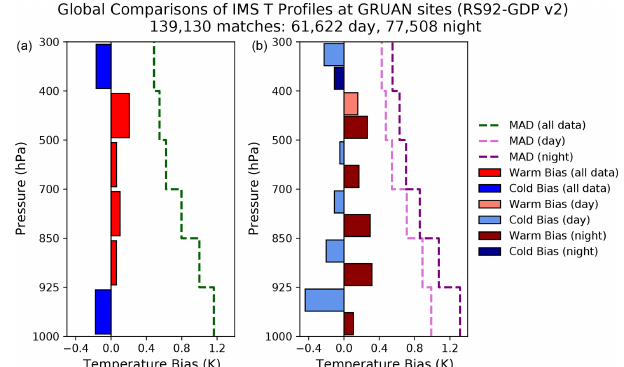
Figure 7. Like Fig. 6 but for comparisons of IMS IASI temperature profiles at GRUAN sites. Median biases for atmospheric layers are shown with red bars representing a median warm bias relative to GRUAN. In contrast, dark blue bars depict a median cold bias with respect to GRUAN. The dashed lines represent the layer median absolute deviation (MAD) in